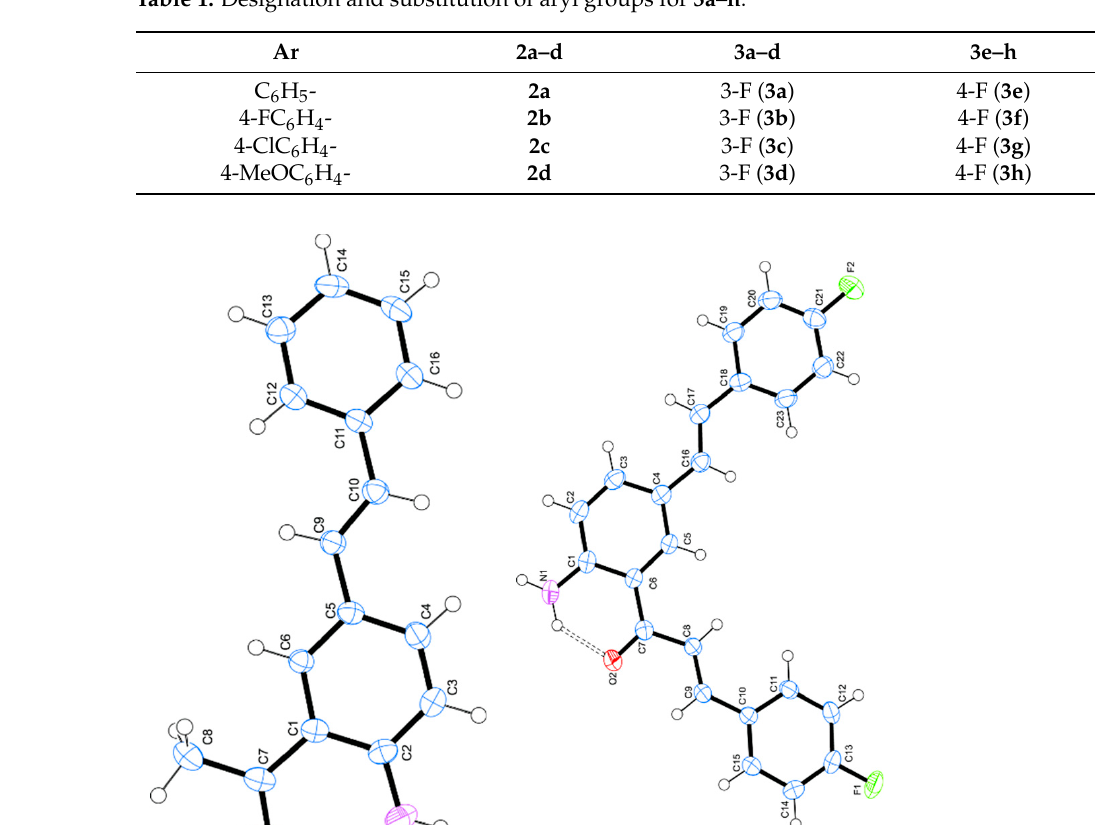
Table 1. Designation and substitution of aryl groups for 3a – h .